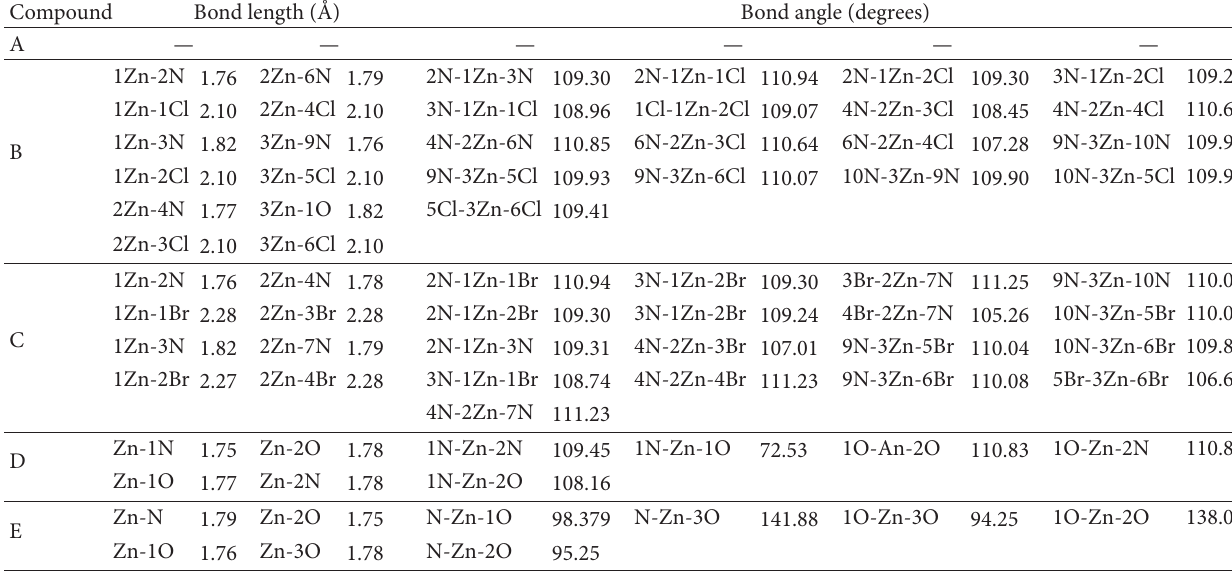
T 5: Molecular modeling data.